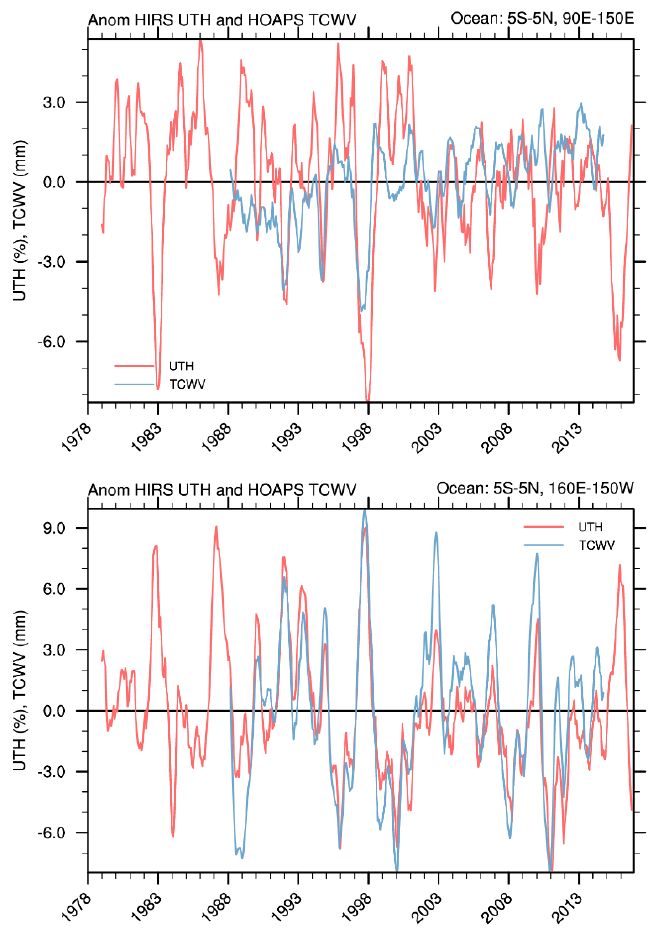
Figure 2. Time series of UTH and TCWV monthly anomalies for the equatorial western Pacific ( upper panel ) and the Niño 4 domain ( lower panel ).